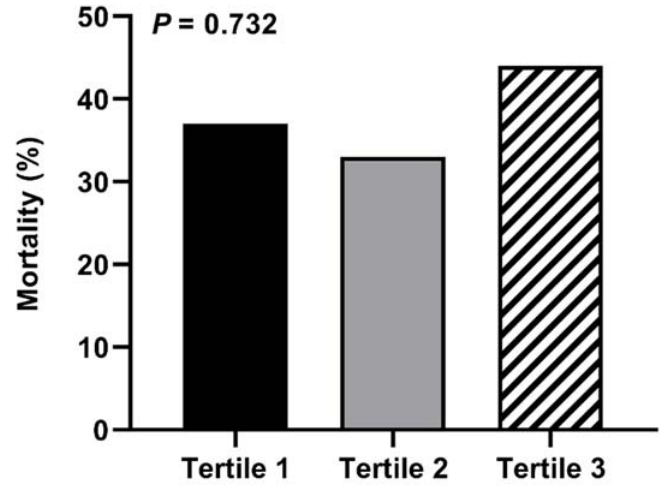
Figure 1. Mortality according to gender-stratified tertiles of CEC.